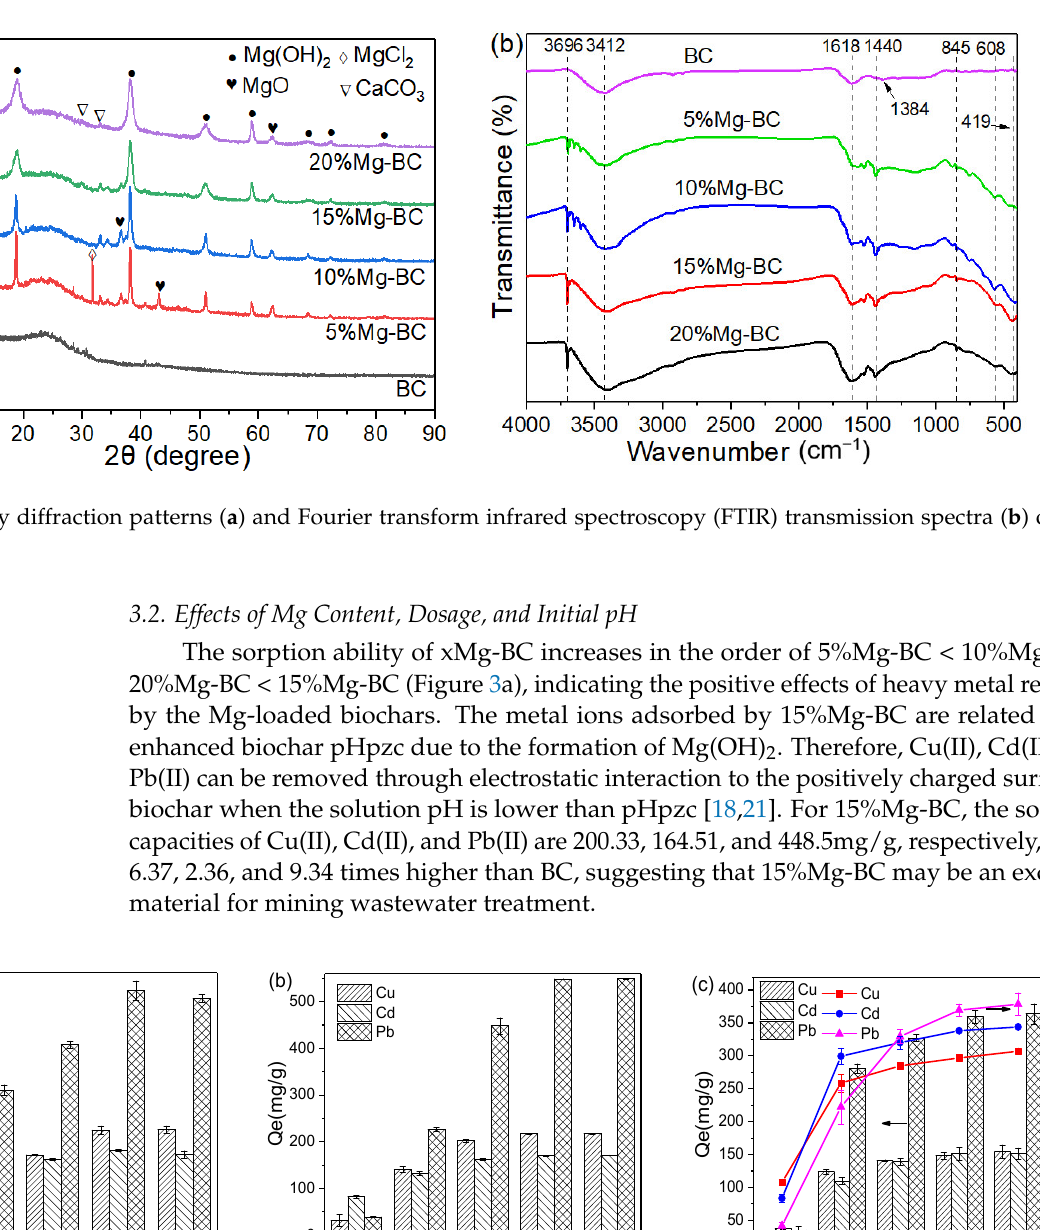
32.45 mg/g to 202.3, 162.57, and 448.33 mg/g, respectively, when the modified biochar dos- age increases from 0.001 g to 0.01 g. While with the further increase in the dosage, metal